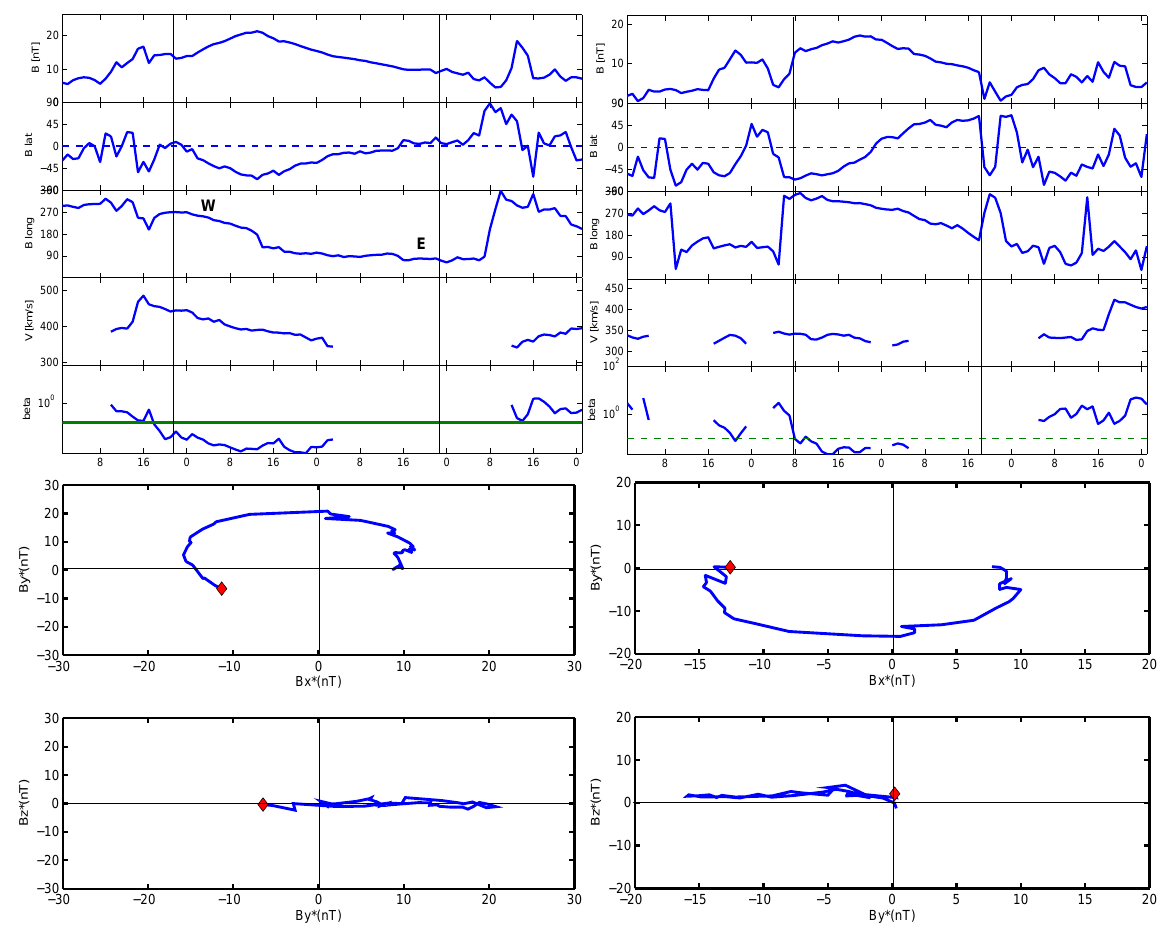
Fig. 2. Top part: Solar wind parameters during two MC events. Top to bottom: magnetic field strength, polar ( Blat ) and azimuthal ( Blong ) angles of the magnetic field vector in GSE coordinate system, solar wind speed and plasma beta. Left: 19–22 March 2001. Right: 19–22 August 1998. Two solid lines indicate the interval of an MC. Bottom part: the rotation of the magnetic field vector in the plane of maximum variance and in the plane of minimum variance. The diamond indicates the start of the